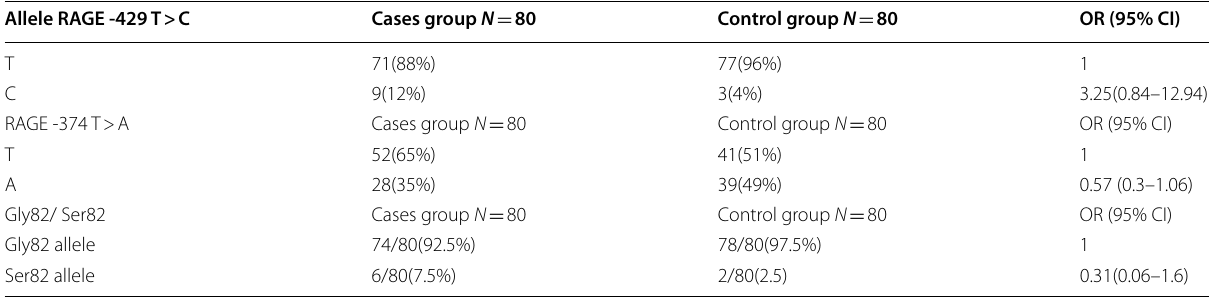
Table 4 Allele frequency for case and control OR ODDS RATIO The increased A allele frequencies was non significantly associated with increased risk HT (OR 0.57 =